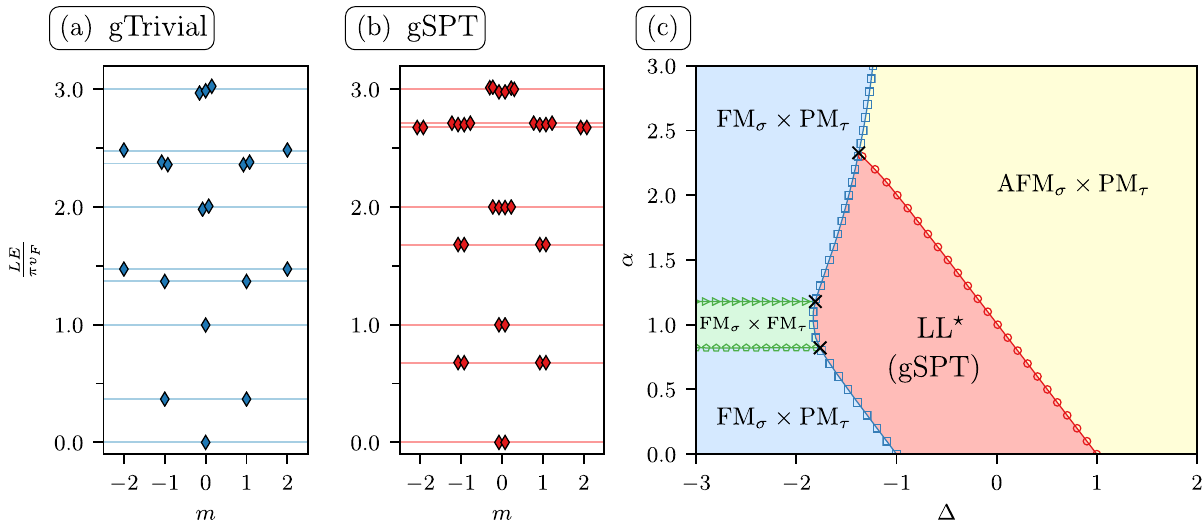
FIG. 5. (a) Spectrum of H LL . (b) Spectrum of the gSPT H LL (cid:3) . For both cases, spectra are normalized to be able to read off CFT gSPT gTrivial operator dimensions. The conformal blocks are labeled by the magnetic charge sector m and spaced horizontally, and small horizontal spacings show degenerate eigenvalues (up to exponential splitting). One can see that the states in the gSPT case are all doubly degenerate, because of the edge modes, but also that operator dimensions have changed relative to the gTrivial case. The numerical spectra were computed via DMRG [92] on up to 32 sites with finite-size scaling, and the solid lines correspond to the exponents − cos π g [93]. To improve convergence, the gap on the paramagnetic sector was increased expected from boundary CFT using Δ eff ¼ from one to ten. (c) The phase diagram of H LL (cid:3) , as computed via DMRG [92]. Each line denotes a different eigenvalue crossing, which gSPT accompanies a phase transition, and black crosses denote multicritical points. The Hamiltonian parameters used are Δ ¼ − 0 . 5 , α ¼ 0 . 1 , g τ ¼ 0 . 3 , and u τ ¼ 0 . 1 for (a), (b), and